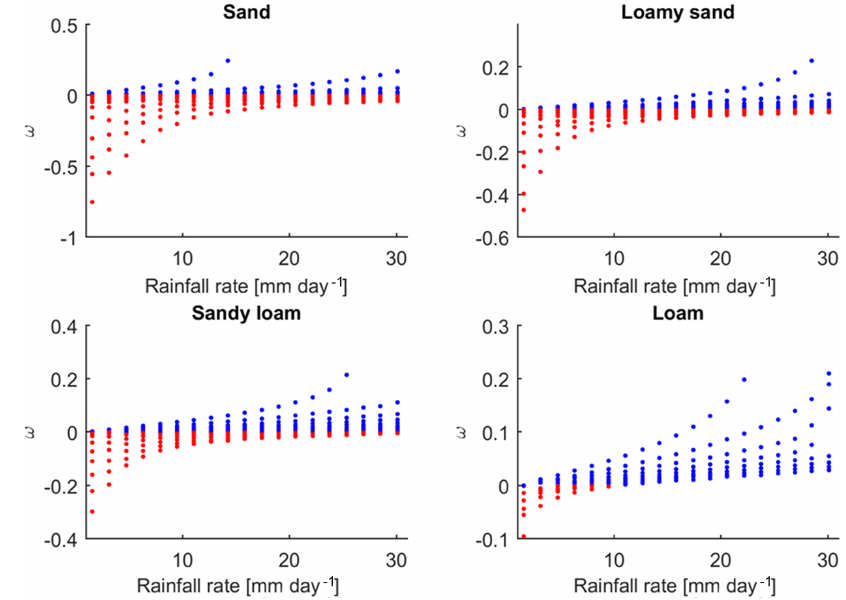
Figure 7. Variations in ω against rainfall intensity for different initial water table level and soil types.